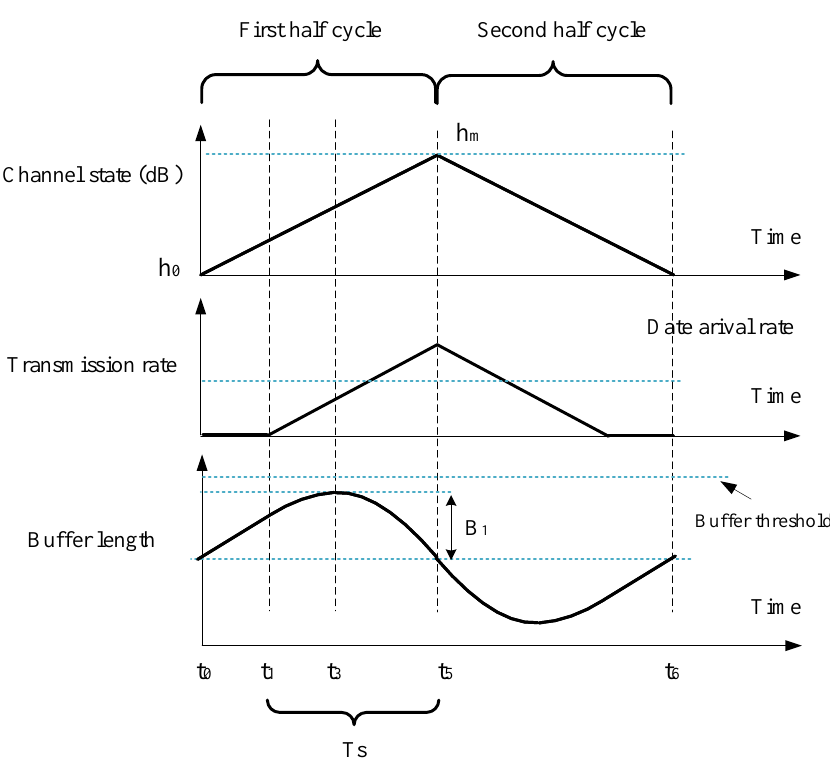
Figure 9. Transmission action when buffer threshold is long enough ( B c ≥ 2 B 1 ), for case